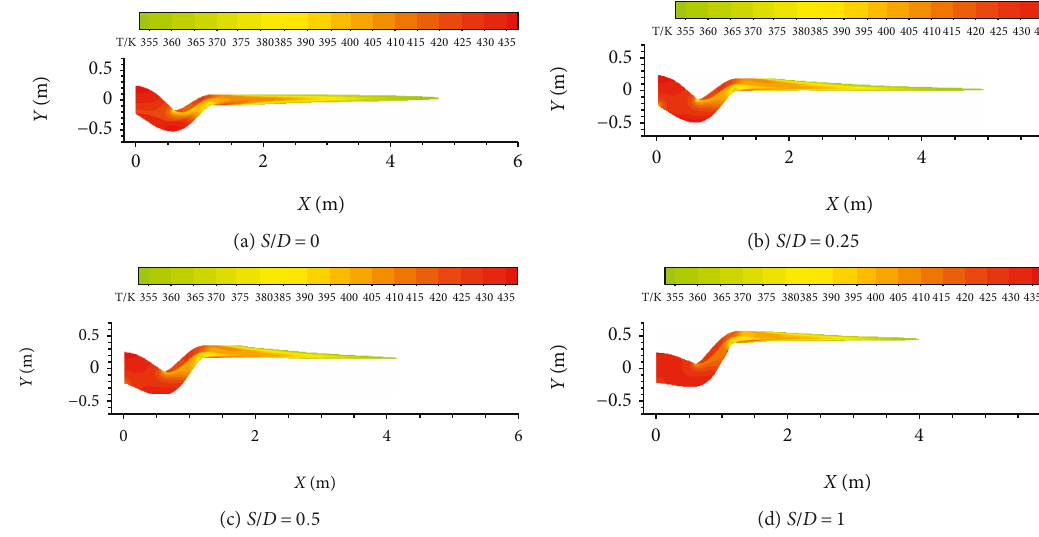
Figure 24: Static temperature on the symmetrical section above 350 K varying S / D